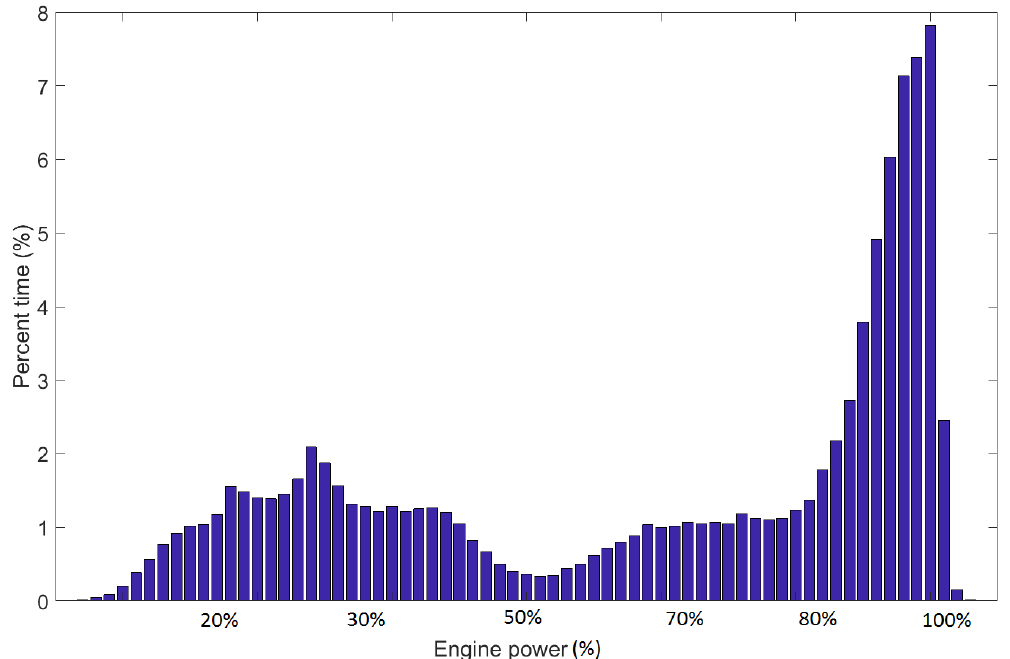
Figure 1. Example of a load profile for a typical ferry